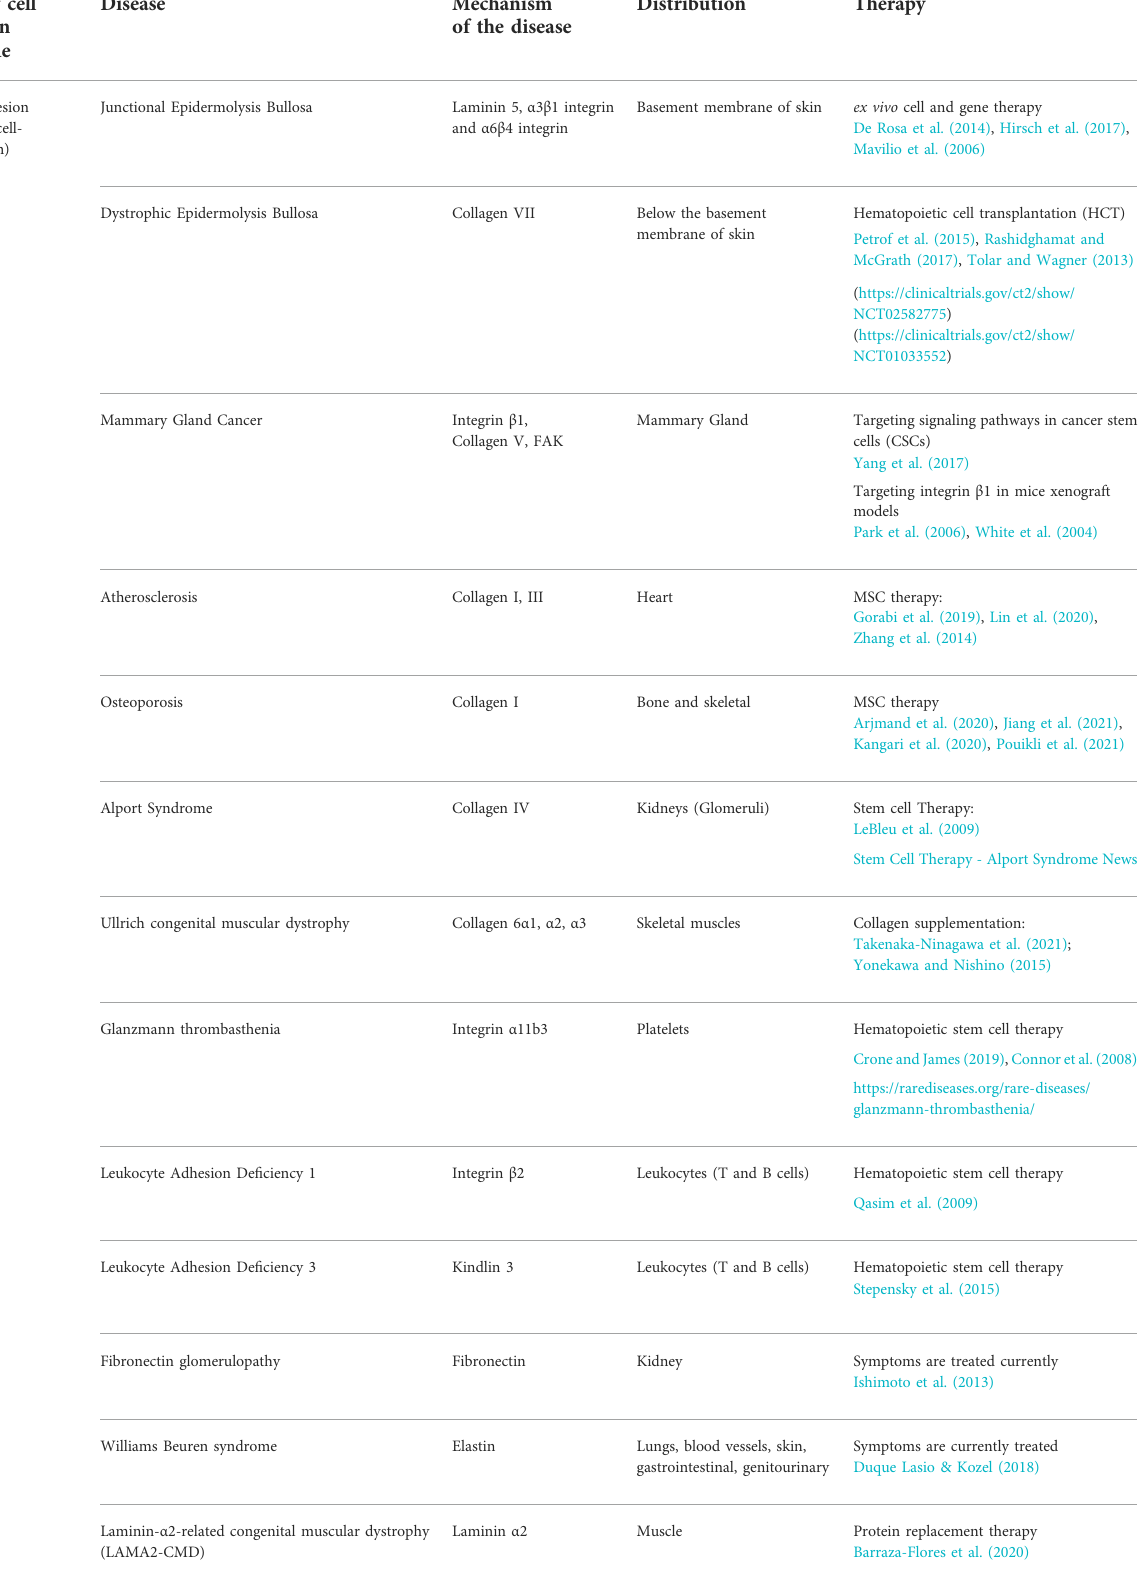
TABLE 1 Diseases associated with cell adhesion